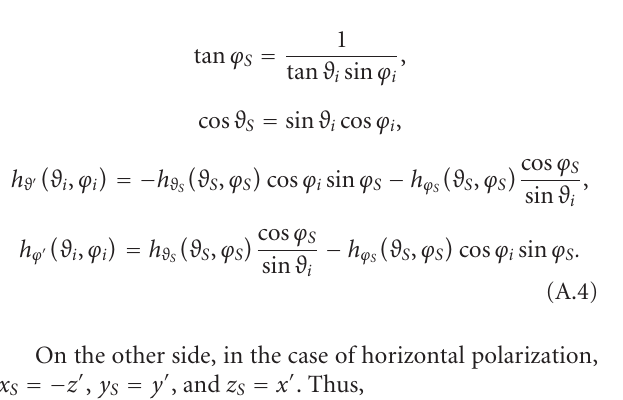
Accordingly, in the case of vertical polarization, x S = y (cid:2) , y S = z (cid:2) , and z S = x (cid:2) (see Figure 21).